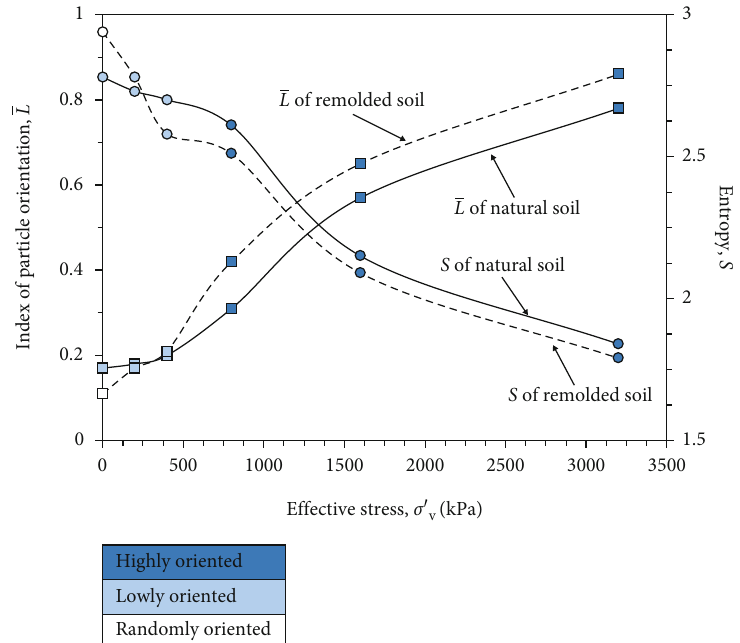
Figure 10: Evaluation parameters for particle orientation of natural and remolded GRS at di ff erent compression